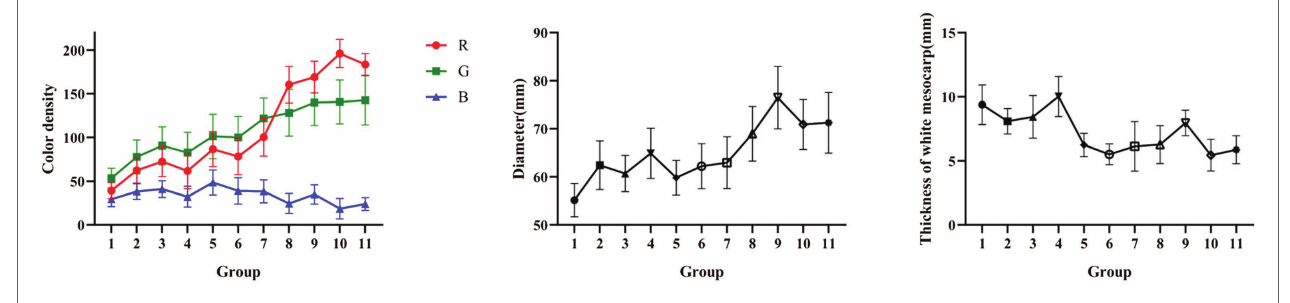
FIGURE 3 | Measurement of appearance